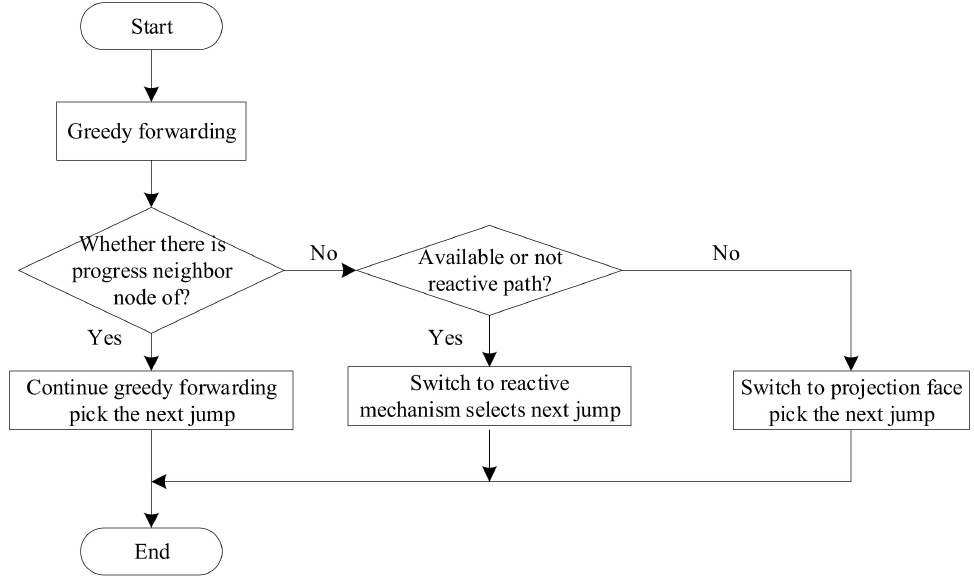
Figure 8. Switching conditions under greedy